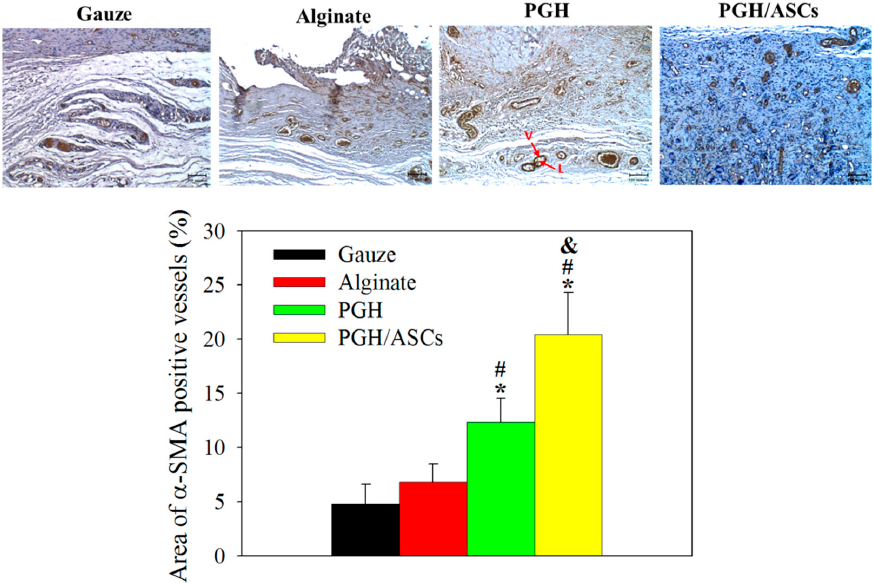
Figure 10. The representative immunohistochemical (IHC) staining images of α -smooth muscle actin ( α -SMA) (bar = 100 μ m; V, vessel; L, lumen) in wound tissues of SD rats after treatment with gauze, alginate wound dressing, PGH, or PCH/ASCs for 14 days, and the area percentage of α -SMA-positive vessels ( n = 4). * p < 0.05 compared with gauze; # p < 0.05 compared with alginate; & p < 0.05 compared with PGH.